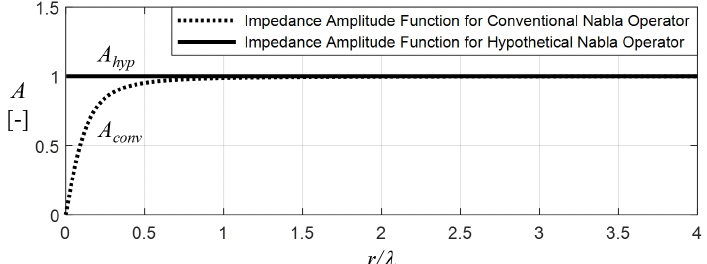
Figure 1. Comparison of the impedance amplitude functions A conv and A hyp for spherical wave propagation as a function of the normalized distance r / λ [-]. At r / λ = 1 the difference is 1.2%, for r / λ > 3 it is less than 0.14%. In practice, the near field influence is neglected in calculations.